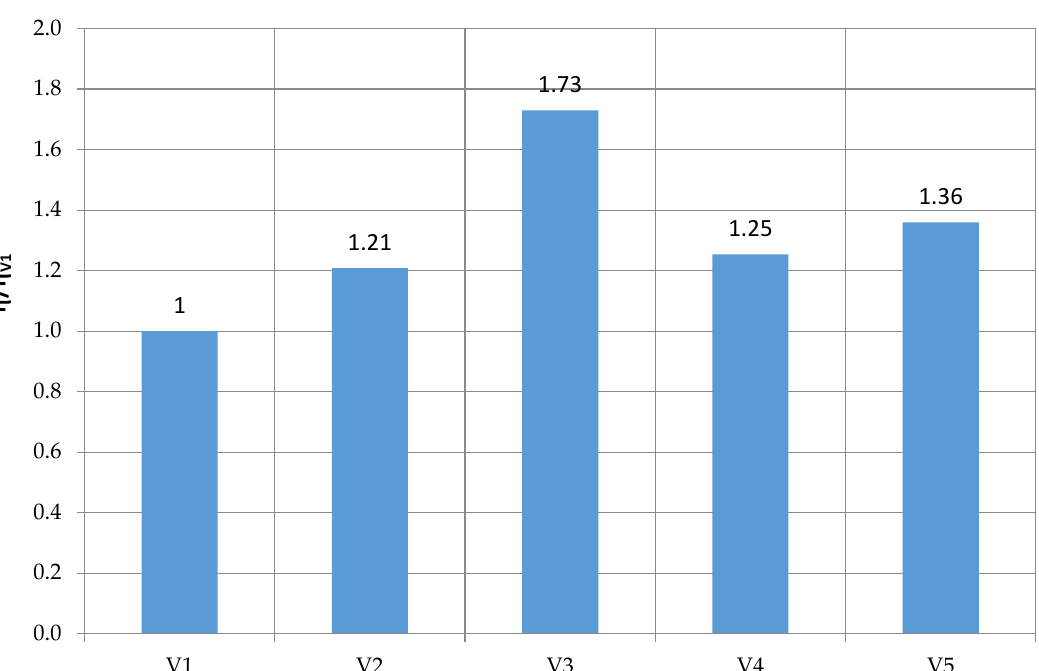
Figure 9. The influence of the cycle structure on its efficiency as compared to variant 1 for methane.